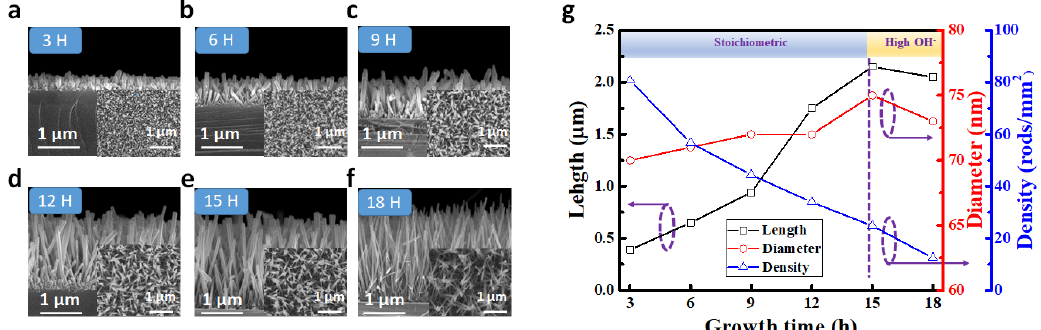
Figure 2. FESEM images of ZnO NRs grown for different growth times. ( a – f ) Cross-section and top-view FESEM images of ZnO NRs for growth times of 3, 6, 9, 12, 15, and 18 h, respectively. ( g ) The variations in the average diameter, length, and areal density for the grown ZnO NRs.